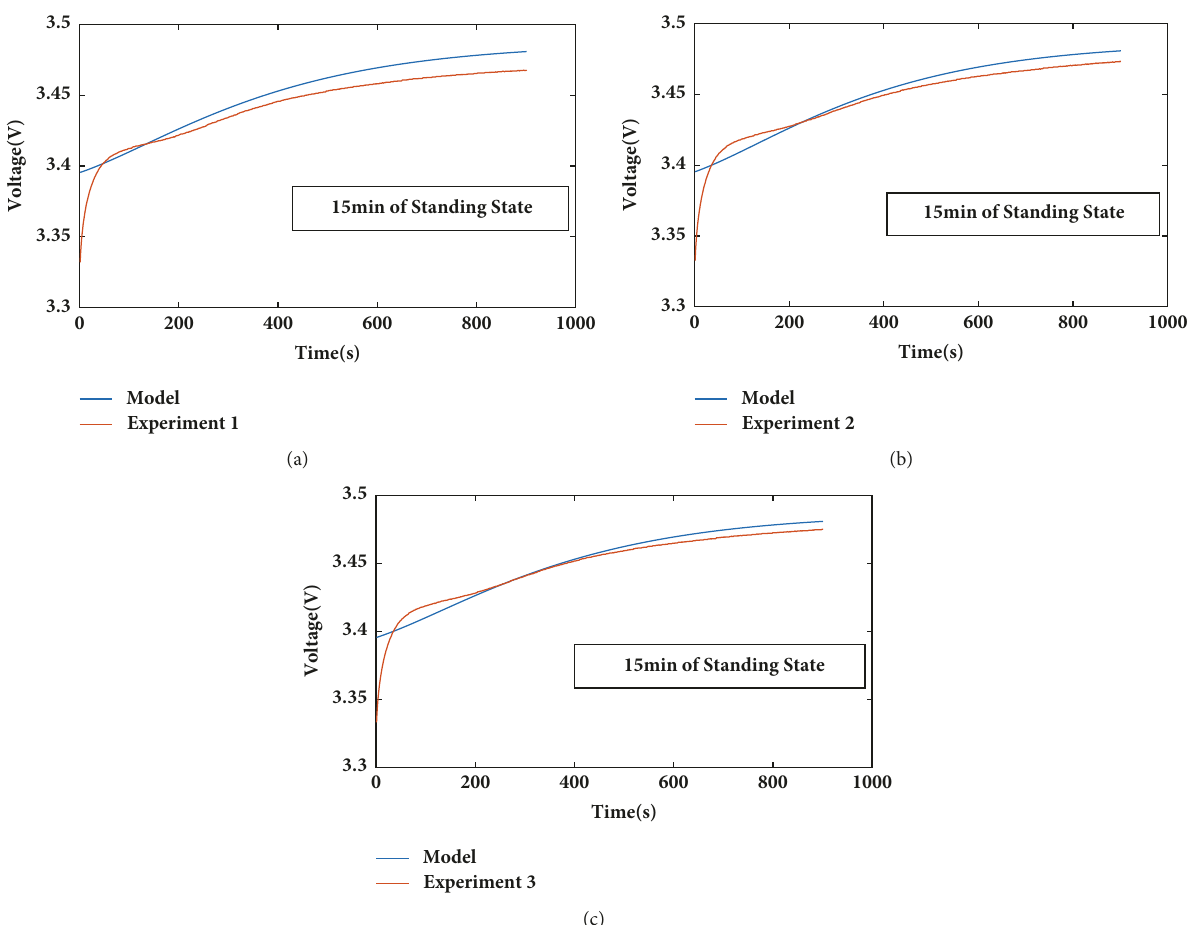
Figure 10: Comparison of model simulations and measurements at self-healing time of 15 minutes, (a) experiment 1, (b) experiment 2, and (c) experiment